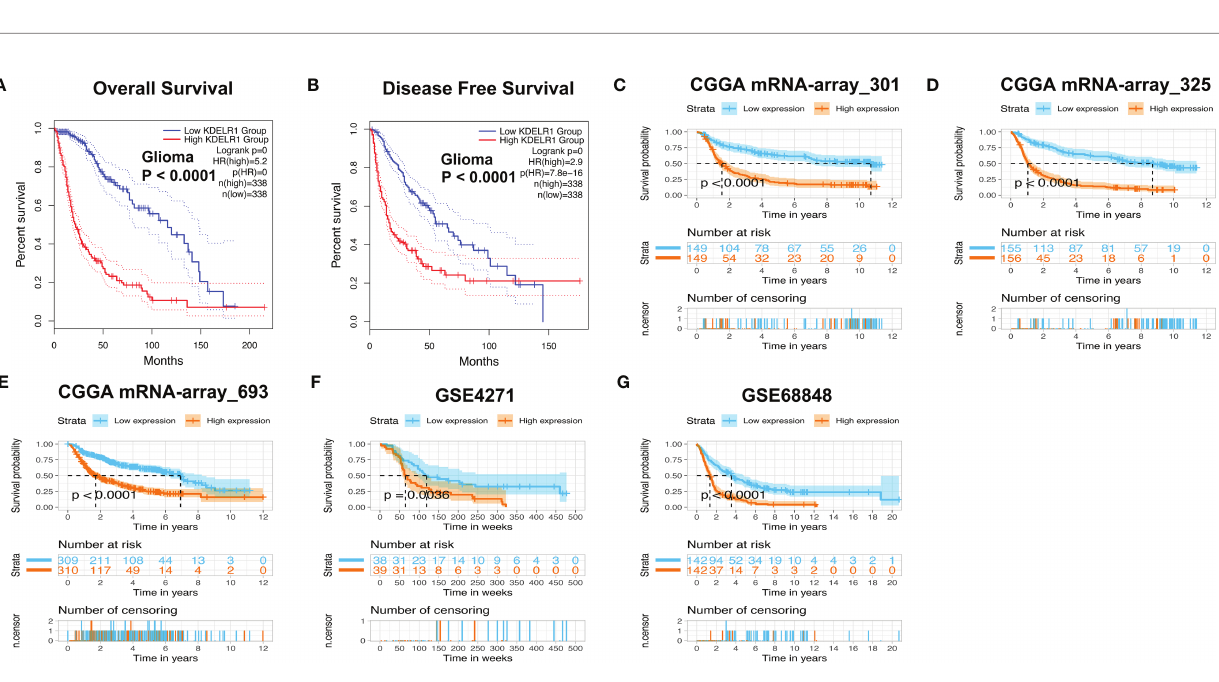
FIGURE 7 | Survival analyses of KDELR1 in different datasets. (A, B) The low-KDELR1-expression group had a shorter overall survival (OS) and disease-free survival (DFS) time than the high-KDELR1-expression group using the online tool GEPIA2, respectively. (C – G) The low-KDELR1-expression group had a shorter OS time than the high-KDELR1-expression group using R language in the different datasets, including mRNA-array_301, mRNA-array_325, and mRNA-array_693 of CGGA, GSE4271, and GSE68848, respectively.